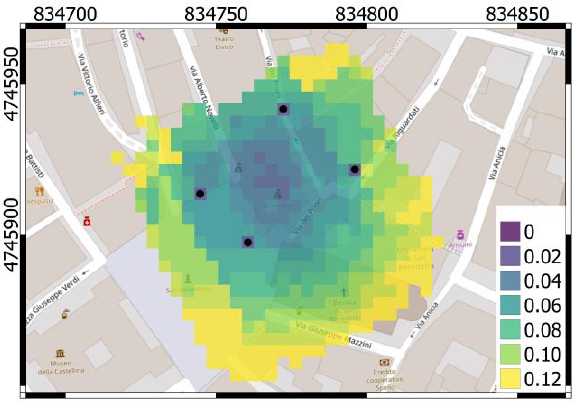
Figure 7. Estimated precisions [m] along Z